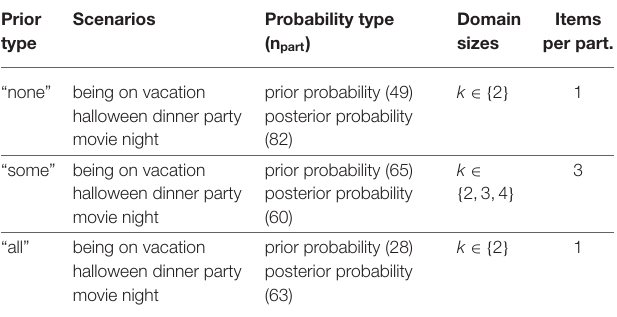
TABLE 3 | Possible combination of elements used in the items for Experiment